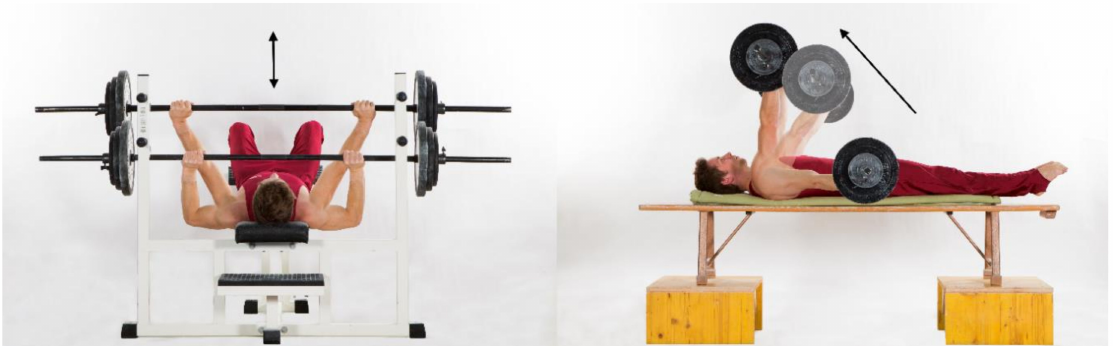
Figure 2. Preconditioning strengthening exercises. Execution of the one-repetition maximum test for the bench press ( left ) and swallow supine position ( right )